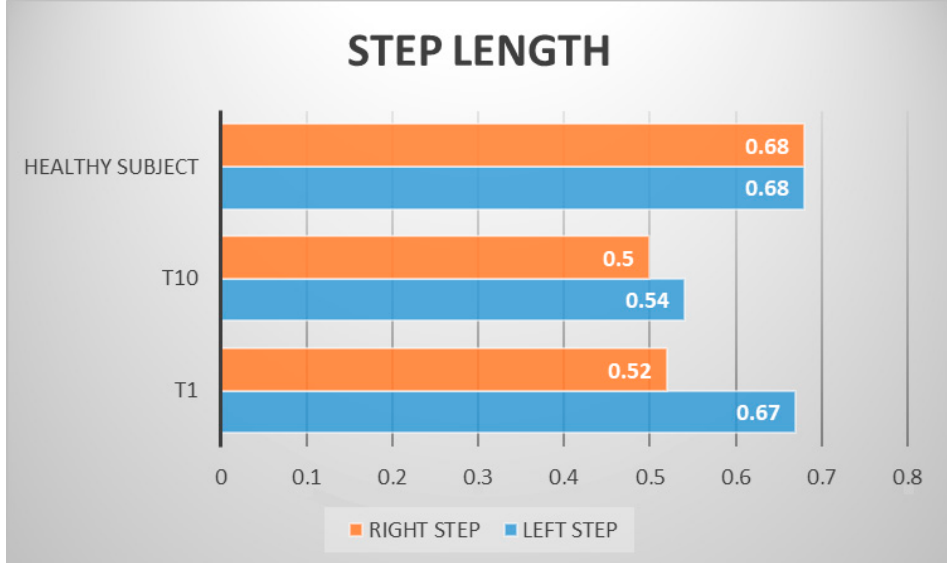
Figure 4. Left and right step length differences between initial and final evaluation; as shown, the patient had, at first, an asymmetrical gait pattern, with a delta left/right leg step of 15 cm. At final evaluation, this difference was diminished to 4 cm; this improvement shows that one of RAGT training’s advantages is the reaching of a symmetrical movement pattern.